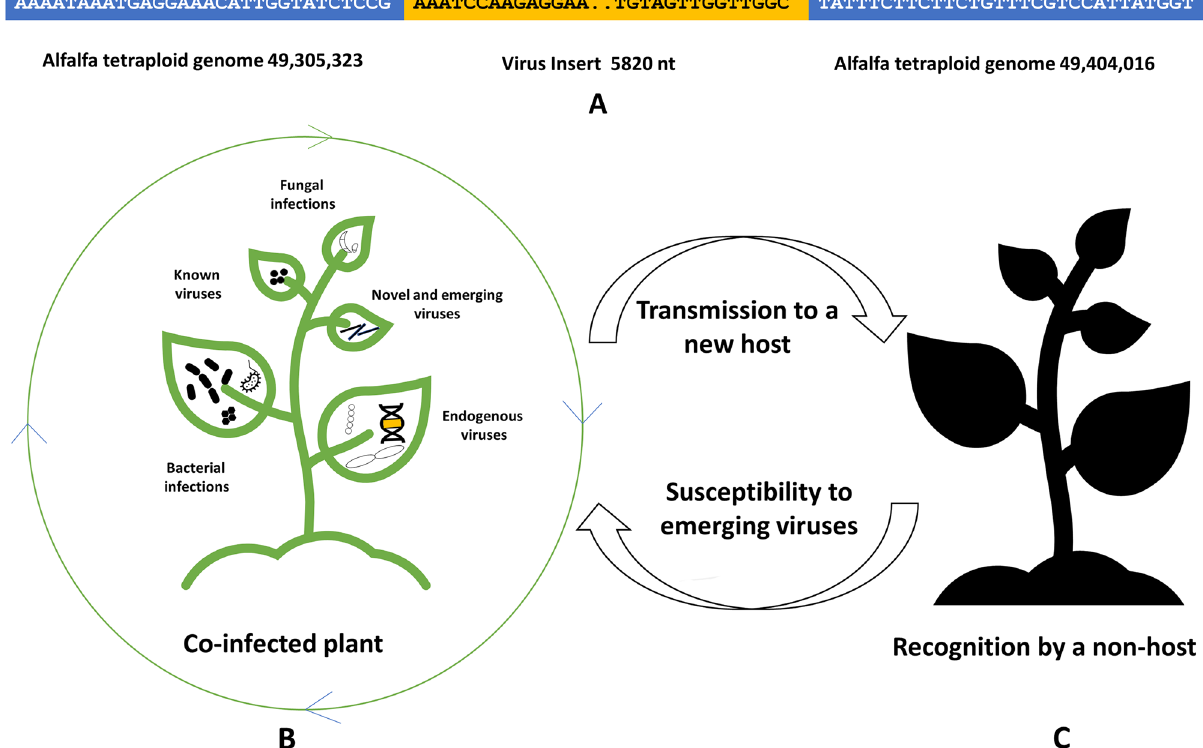
Figure 7. Example of the viral insert in chromosome 8.3 of the tetraploid alfalfa genome ( A ) and a simplified representation of the evolution of pathogen virulence and reduction of host fitness in co-infected plants ( B , C ). ( A ) Blue rectangular boxes: portions of alfalfa tetraploid genomes surrounding the viral insert. Yellow rectangular box: 820 nucleotides-long viral insert. Dots indicate continuous nucleotide sequence. ( B ) Multi- pathogen interactions of different types may increase genetic diversity of microbes, result in novel recombinant genotypes, and impact host susceptibility and defense responses. ( C ) Consequently, transmission rates may change, following by host range